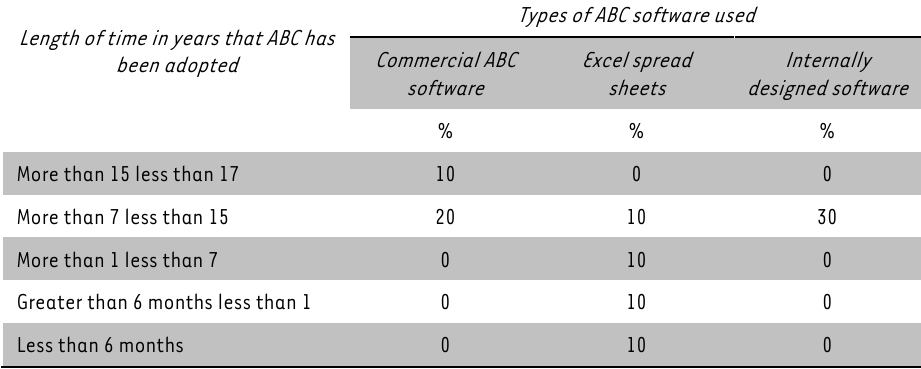
TABLE 5: Breakdown of the type of ABC software in relation to the length of time ABC has been adopted Types of ABC software used Length of time in years that ABC has Commercial ABC Excel spread been adopted software sheets